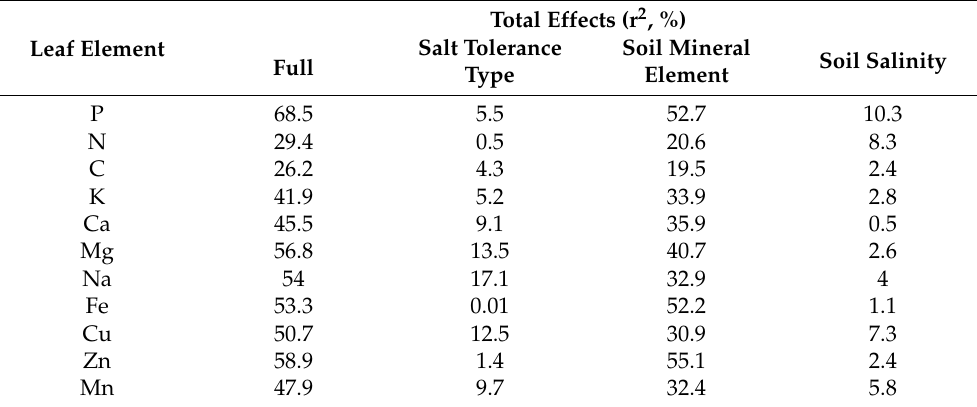
Table 3. Summary of the general linear models for the effects of salt tolerance type, soil salinity property and soil mineral element factors on the concentrations of mineral elements in leaves.